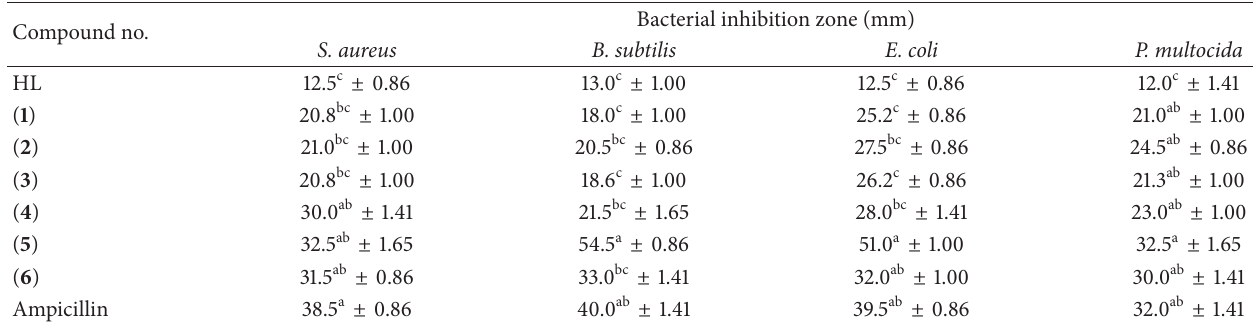
Table 5: Antibacterial activity data a–e of complexes and ligand against selected bacterial strains. Compound no.